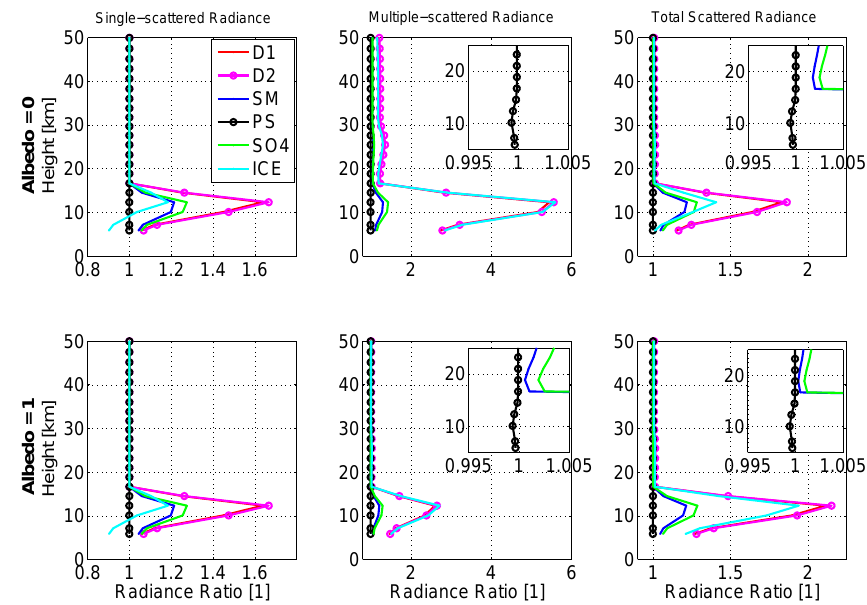
Fig. 10. As in Fig. 7 but at 813nm. D2 obscures D1 almost completely due to low D1 absorption at